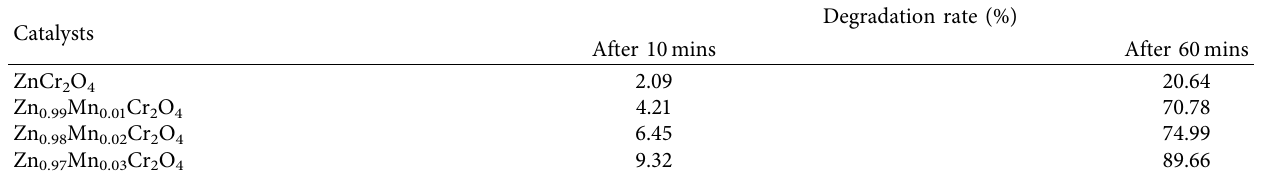
Figure 4: Degradation curves of methylene blue with (a) pristine ZnCr Table 4: Photocatalytic degradation efciency of ZnCr